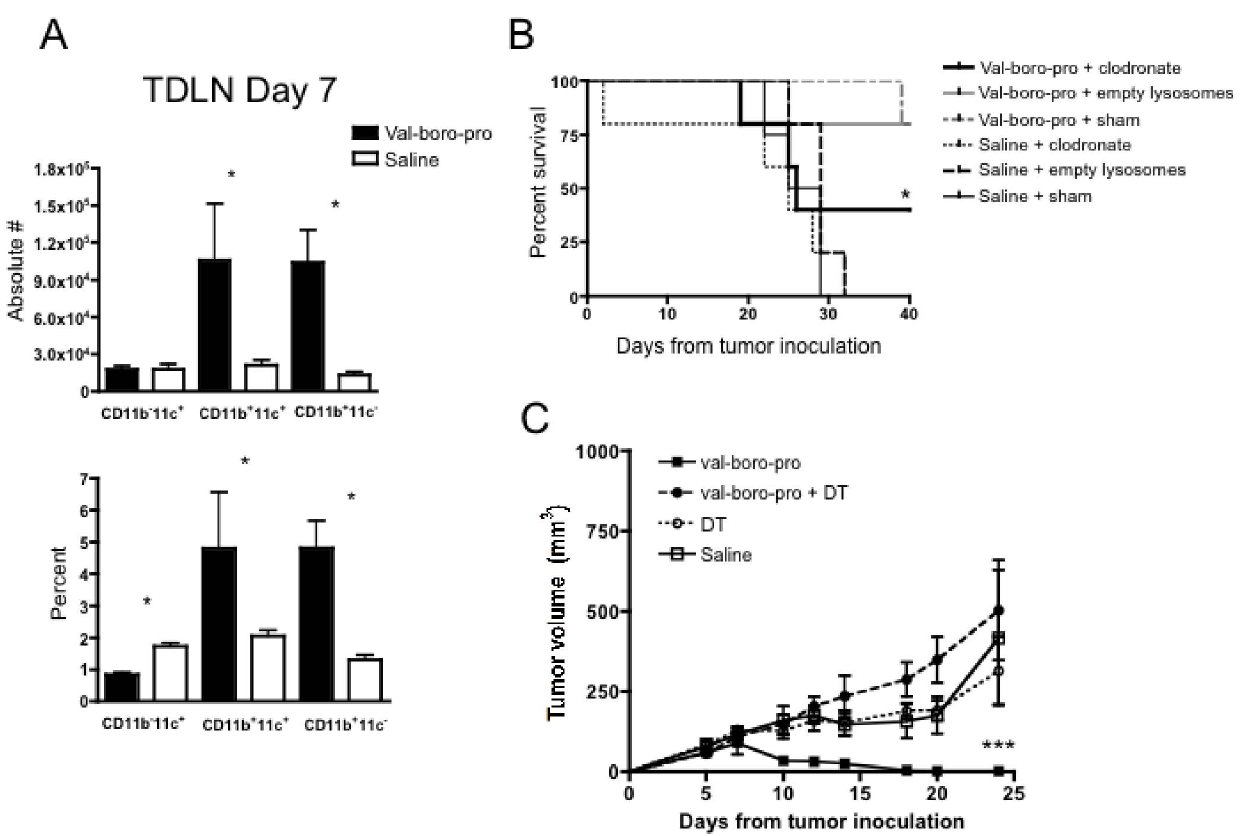
Figure 7. Myeloid dendritic cells (CD11b + CD11c + ) are increased in TDLN and are required for tumor regression. (A) C57BL/6 mice were challenged with 1 6 10 6 MB49 on day 0 and treated with Val-boroPro (closed bars) or saline (open bars) during week one (n=4/group). Tumor- draining lymph nodes were harvested and analyzed by flow cytometry on day 7 (p , 0.05, Mann-Whitney) (B) C57BL/6 mice were inoculated with 10 6 MB49 and injected with clodronate IP (0.1 mL/10 g body weight) every other day from day –1 to 9 following tumor inoculation. Control groups were injected with empty lysosomes or saline (sham). Val-boroPro was administered orally for 1 week (days 3–7). Survival was significantly different in Val- boroPro treated mice given clodronate (thick solid line) compared to those treated with Val-boro-Pro and given empty lysosomes (gray solid line) (*p , 0.05, Logrank test, n=5/group). (C) CD11c-diphtheria toxin (DT) chimeric mice were generated by transplanting bone marrow from CD11c-DT transgenic mice into lethally irradiated C57BL/6 recipients (n=5/group). Female chimeras were inoculated with 10 6 MB49 on day 0 and treated with Val-boroPro or saline during week one (days 3–7) with or without IP injections of DT (8 ng/1 g body weight) every other day from day –1 to 9. Tumor volumes were significantly larger in Val-boroPro treated chimeric mice receiving DT (closed circles) compared to Val-boro-Pro treated chimeric mice receiving saline (closed squares) (p , 0.001 for all timepoints beyond day 10). Tumor volumes were not statistically different between saline treated (open squares) and DT treated (open circles) chimerics not treated with Val-boroPro. Experiments displayed in Figures 7A–C were each conducted twice.